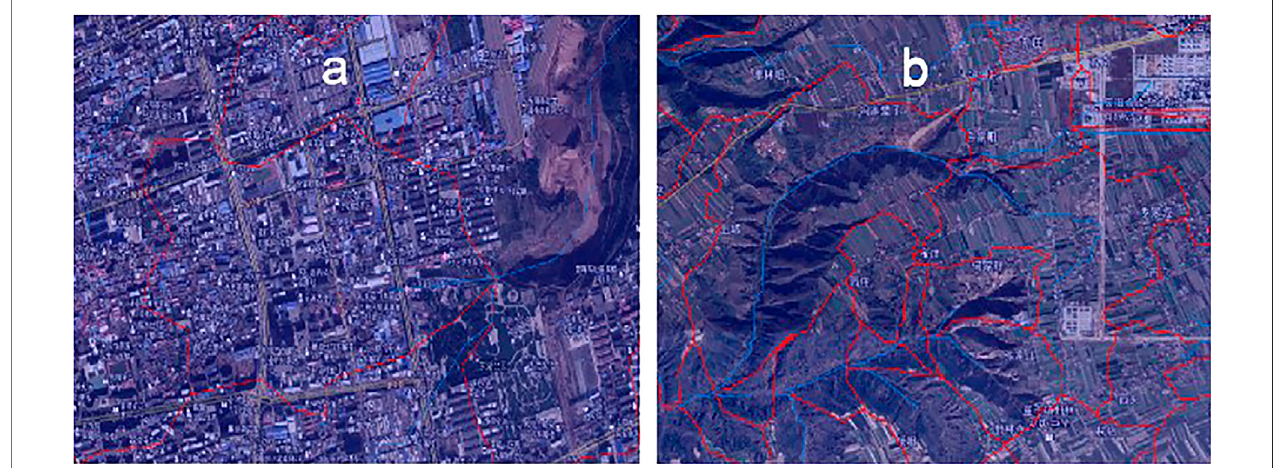
FIGURE 4 | Watershed division of Huoxiang and Fengjiapan gully